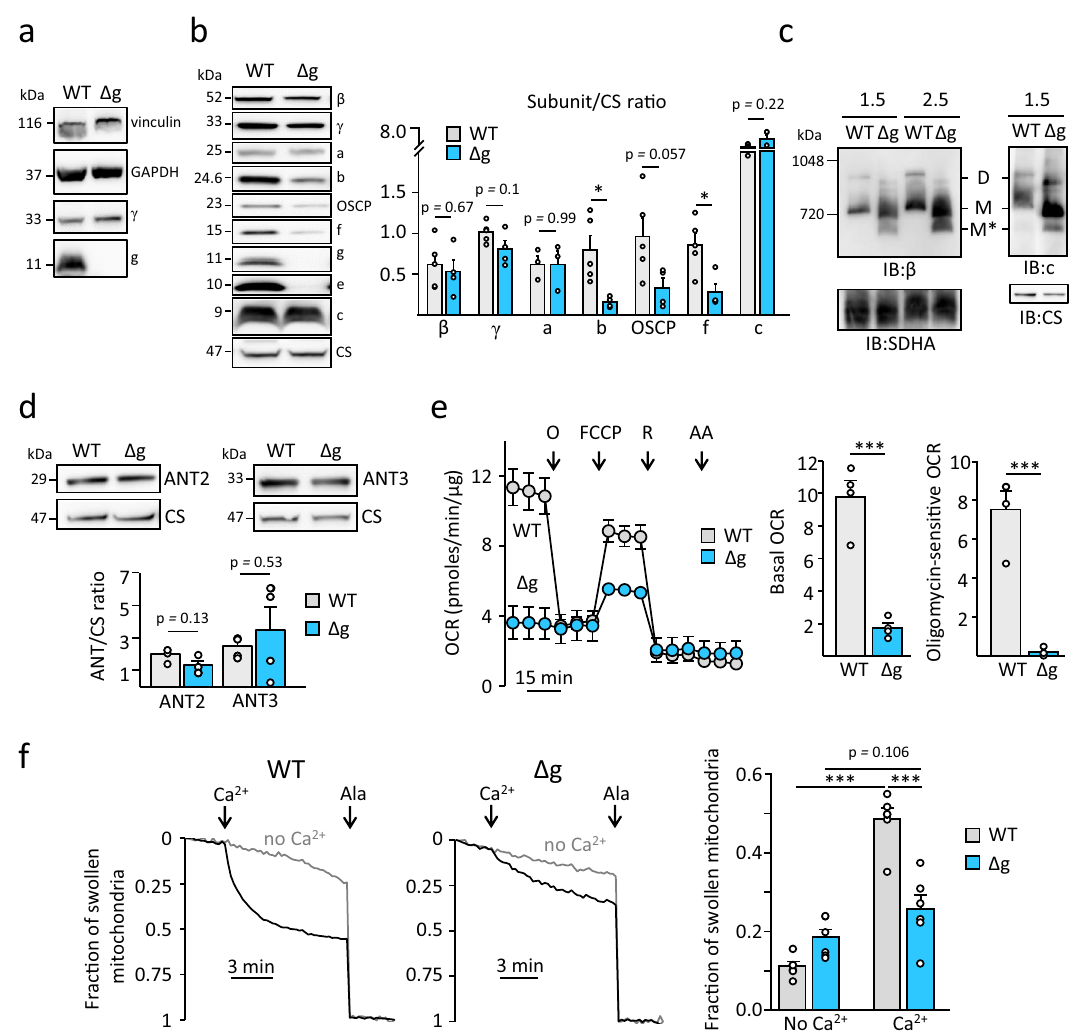
Fig. 1 Characterization of HeLa- Δ g cells. a Western blot analysis of indicated protein in total cell lysates of HeLa- Δ g cells (40 μ g/lane). Images are representative of three independent blots. b Western blot analysis of isolated mitochondria from wild-type (WT) and Δ g cells for the indicated F-ATP synthase subunits. Histogram refers to the quanti fi cation of protein levels relative to citrate synthase (CS) and represents mean ± SEM of 3 (for subunit a) or 4 (for all other subunits) independent blots, * p < 0.05, two-sided Student ’ s t -test. Gray bars, WT and cyan bars, HeLa- Δ g cells. c Clear native-PAGE analysis and subsequent immunoblotting against ATP synthase subunits β , c, and against SDHA of WT and Δ g mitochondria in the presence of indicated amount of digitonin (g digitonin/g protein). Images are representative of two independent blots. d Western blot on isolated mitochondria for ANT2 and ANT3. Histogram refers to the quanti fi cation of protein levels relative to citrate synthase (CS) and represents mean ± SEM of three independent blots. Two-sided Student ’ s t -test. e Mitochondrial oxygen consumption rate (OCR) was evaluated in intact cells by Seahorse XF Analyzer before and after the addition of oligomycin (O), FCCP (100 nM), rotenone (R), and antimycin A (AA). Traces are average of four independent experiments for WT (gray trace) and Δ g cells (cyan trace). Basal and oligomycin-sensitive OCR is expressed as mean ± SEM of four independent experiments, *** p < 0.001 with two-sided Student ’ s t -test. f Swelling assay in isolated mitochondria in the presence (black traces) or absence (red traces) of Ca 2 + . PTP opening was induced with 50 μ M Ca 2 + , and alamethicin (ala) was added where indicated. Histograms refer to the fraction of swollen mitochondria after about 9 min of Ca 2 + addition and are mean ± SEM of six independent experiments, *** p < 0.001, two-sided Student ’ s t